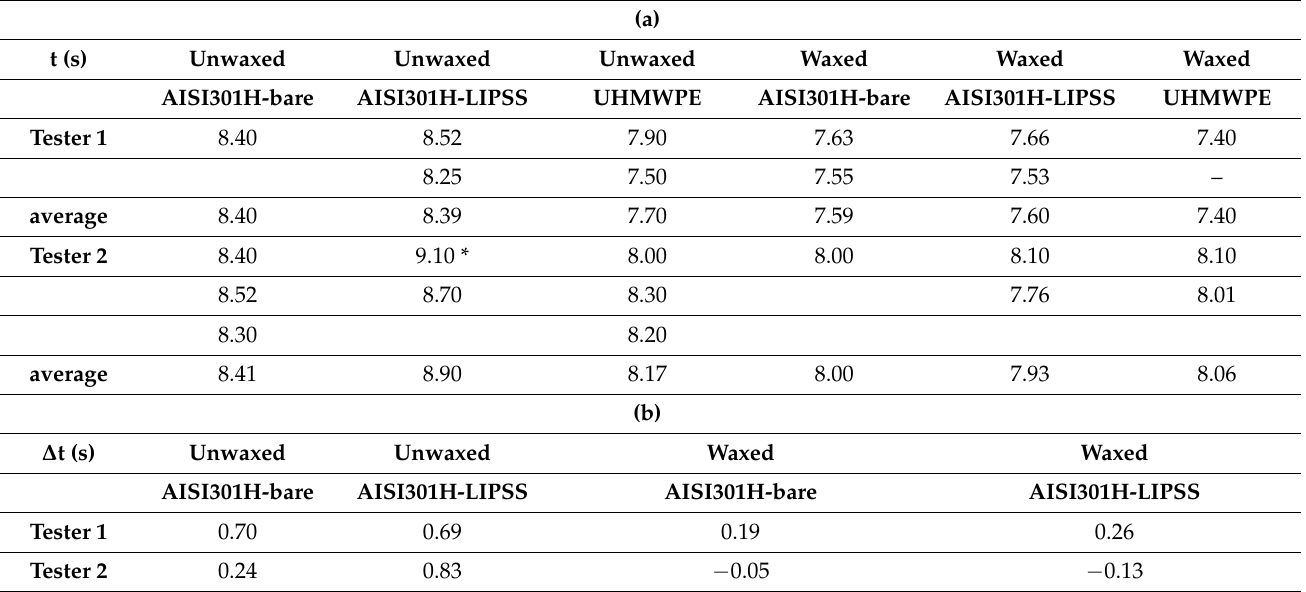
Table 1. ( a ) Collection of travel times (t, seconds) for the two testers equipped with the three different skis. The total mass of Tester 1 was 101.5 kg and that of Tester 2 was 83.5 kg. ( b ) Difference ( ∆ t, seconds) of the average travel times recorded for AISI301H ski bases with respect to UHMWPE. * see text for